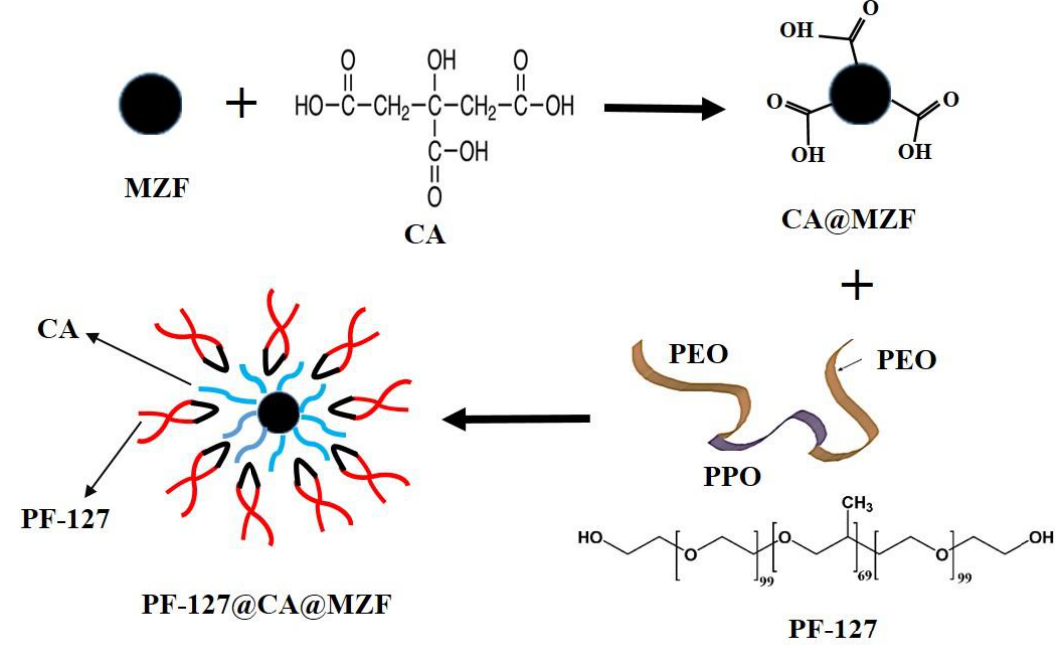
Figure 1. Schematic illustration for the formation of citric acid (CA) and pluronic F127 (PF-127) on the surface of MZF nanoparticles.